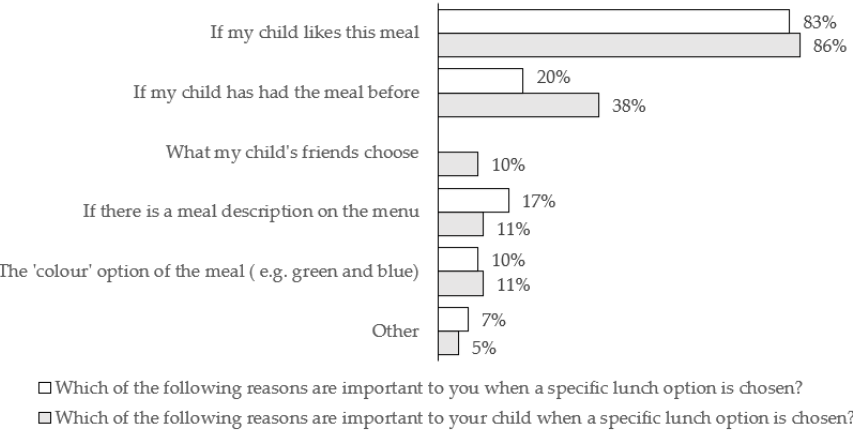
Figure 1. Parents’ perspectives on reasons (for themselves and for their children, separately) that a specific lunch option is chosen, n = 84.